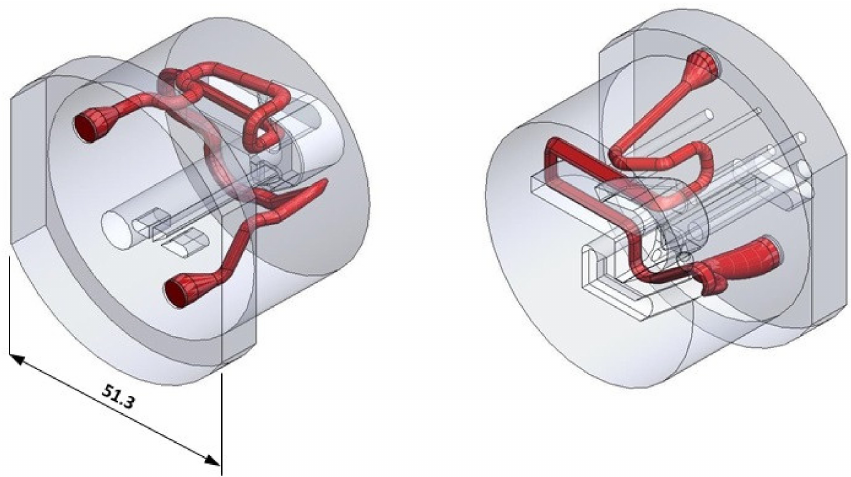
Figure 28. The core/inserts for injection molding optimized by the simulations. Red color = the cooling channels after optimization [62]. The displayed dimension is in mm.